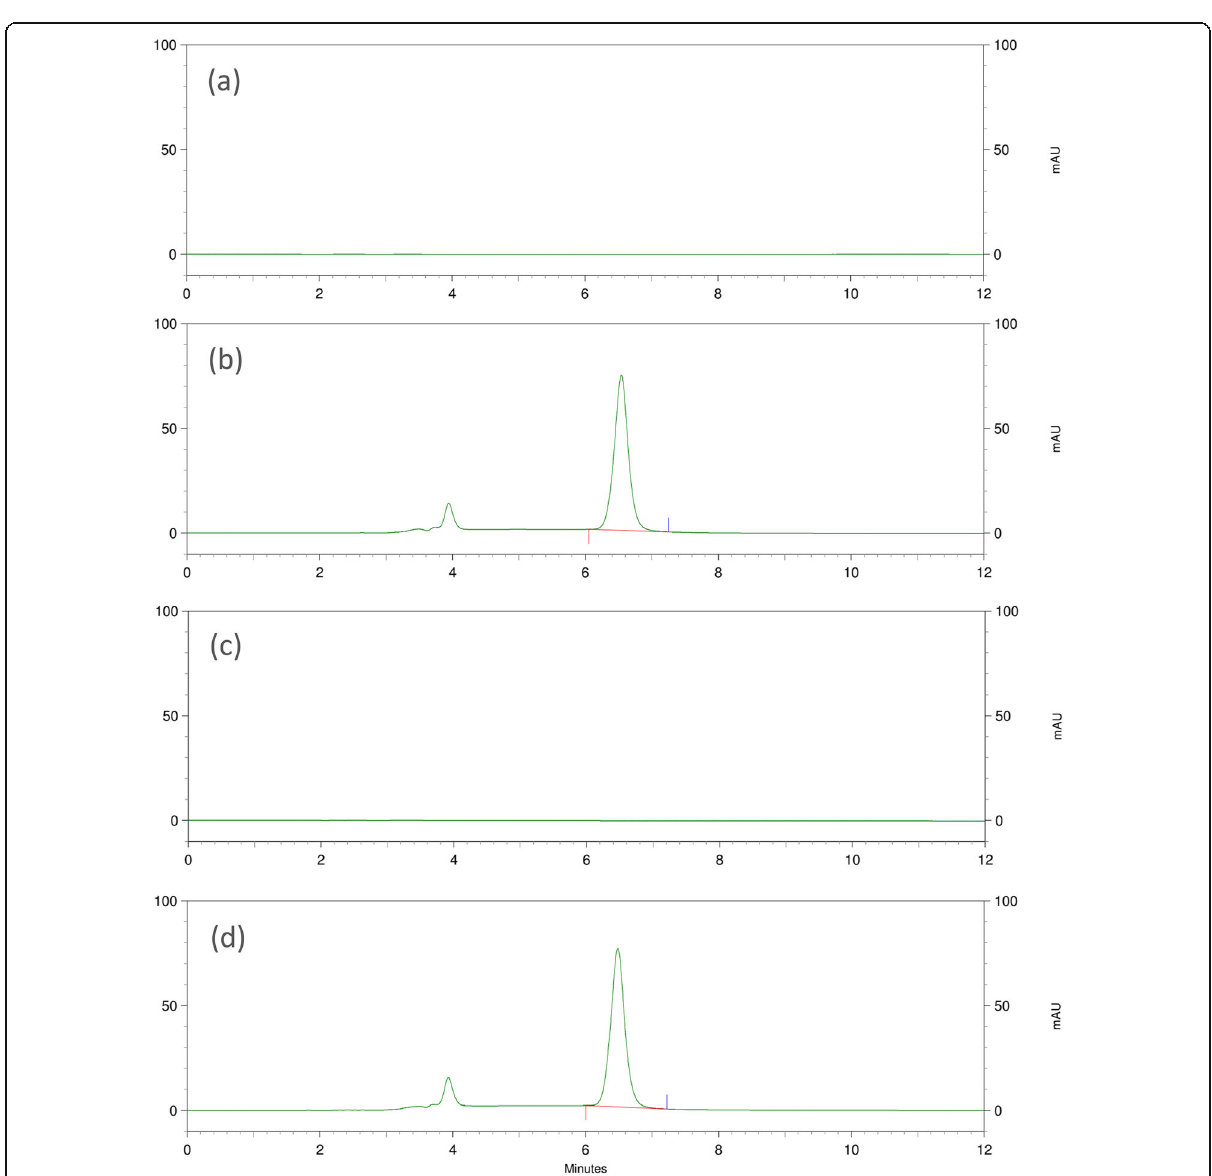
Fig. 2 Chromatograms of ( a ) blank ( b ) tetrahydrocurcumin standard ( c ) placebo ( d ) tetrahydrocurcumin